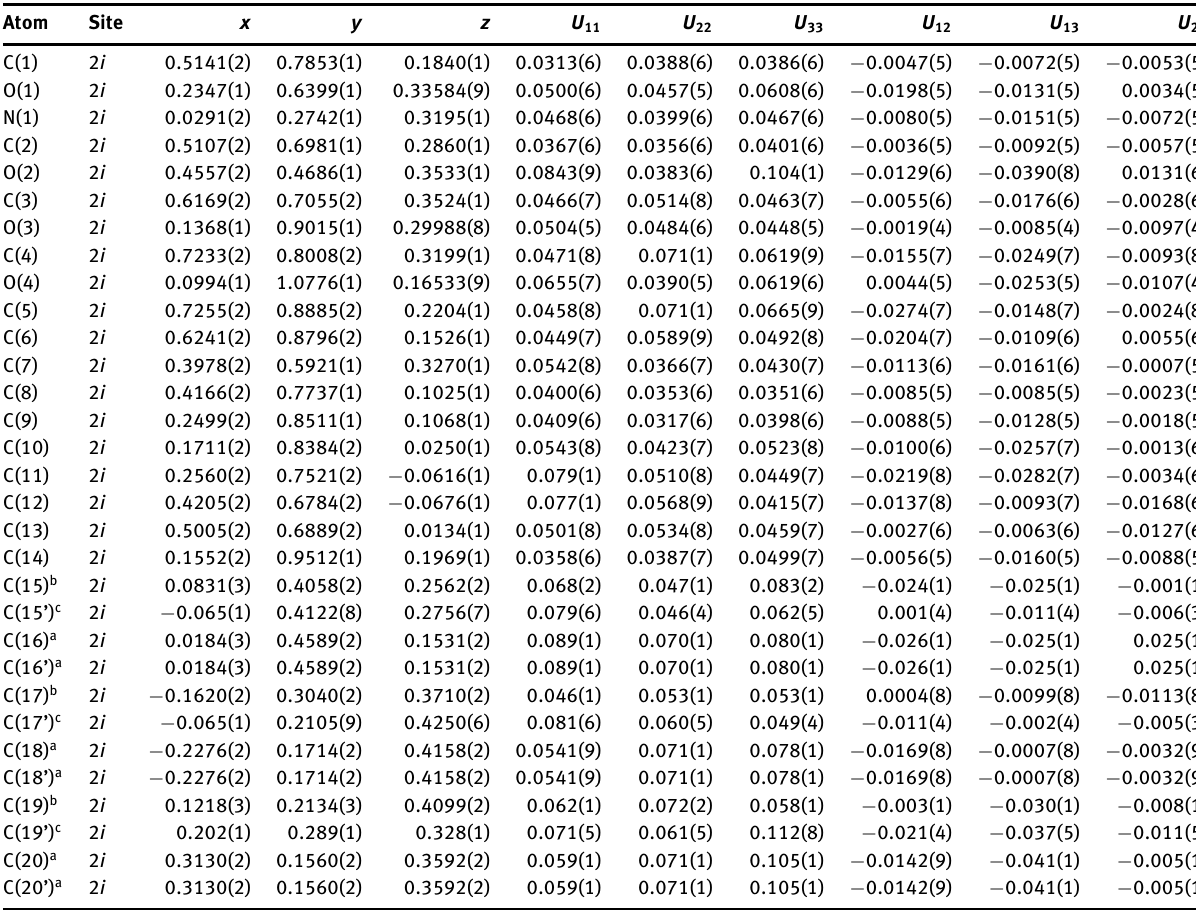
Table 3: Atomic displacement parameters (Å 2